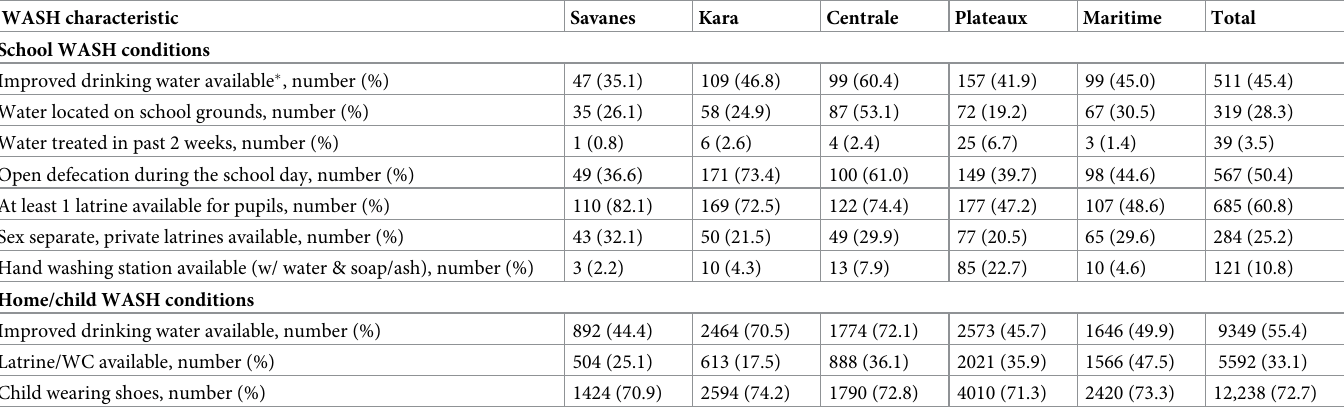
conditions were unavailable and information on students’ home WASH conditions were gath- ered via student interviews at the time of stool sample collection. The spline model for community-level latrine coverage showed lower EPG of stool with increasing latrine coverage that was approximately linear (Fig 1). We did not observe a clear, linear trend between improved community-level drinking water and EPG of stool. Table 3. School and home WASH